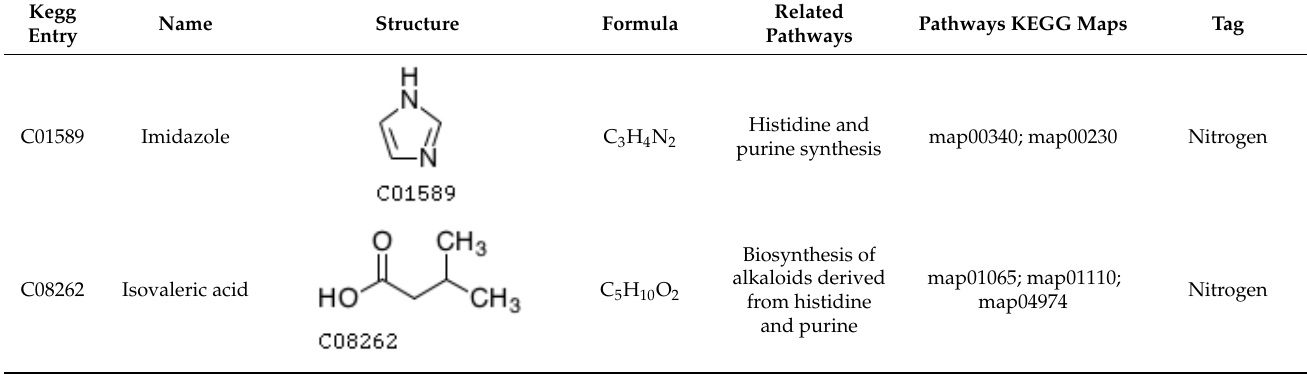
Table 1. The list of molecules detected and identified by GC-MS in A. thaliana cells. All of the molecules that were detected were categorized by their role in plant metabolic pathways following KEGG annotations and the author’s criteria.